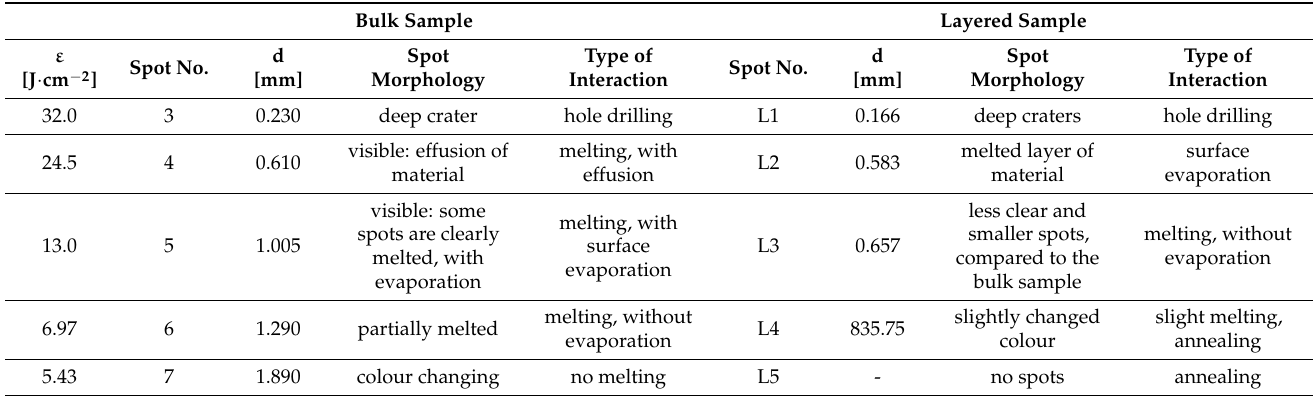
Table 3. Description of the spots in Figure 2.